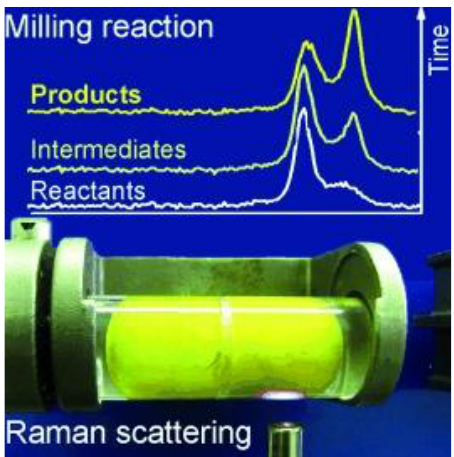
Figure 9. Laboratory Raman spectroscopy experiments for in situ studies of mechanochemical transformations of coordination polymers, organic materials, and liquid additives. Reprinted with permission from [62]. Copyright 2014, John Wiley and Sons.